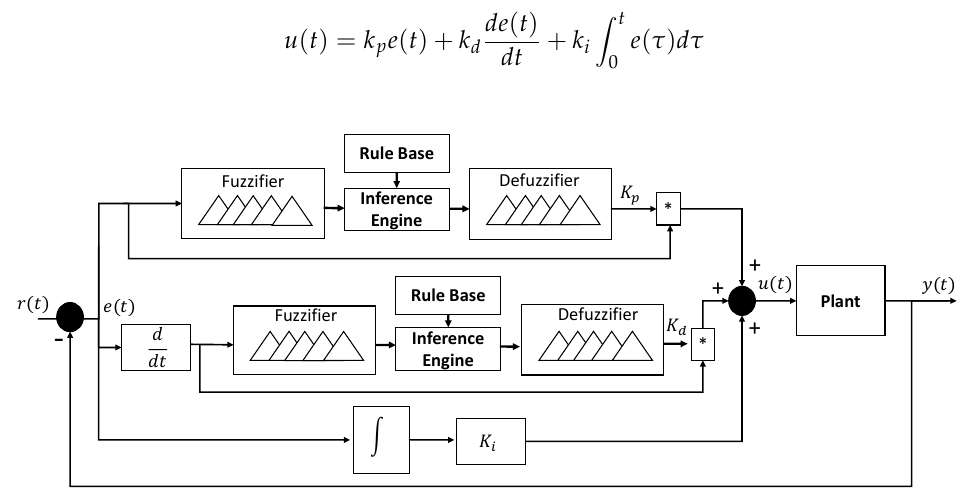
Figure 3. Proportional-Integral-Derivative (PID)-type FLC architecture proposed.